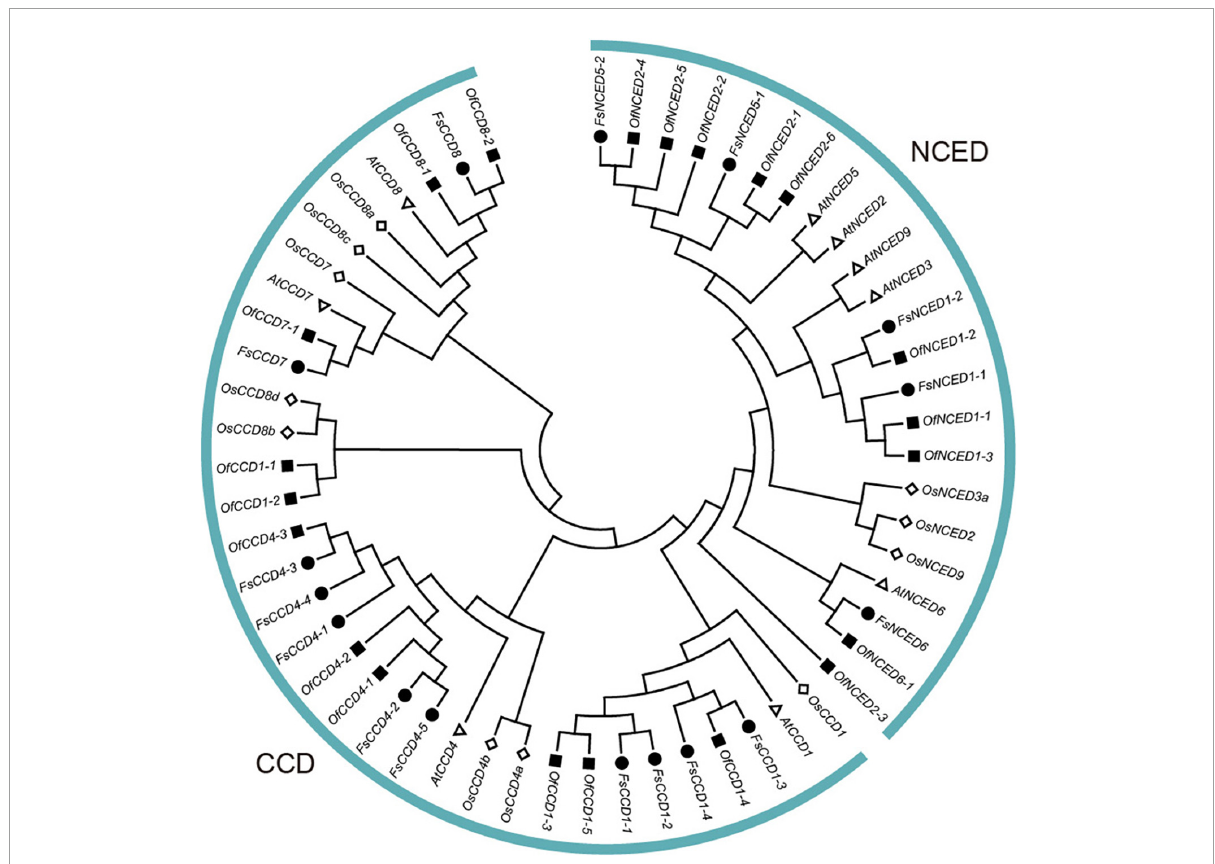
FIGURE2 Phylogenetic tree of CCD proteins in Forsythia suspensa, Osmanthus fragrans, and Arabidopsis thaliana